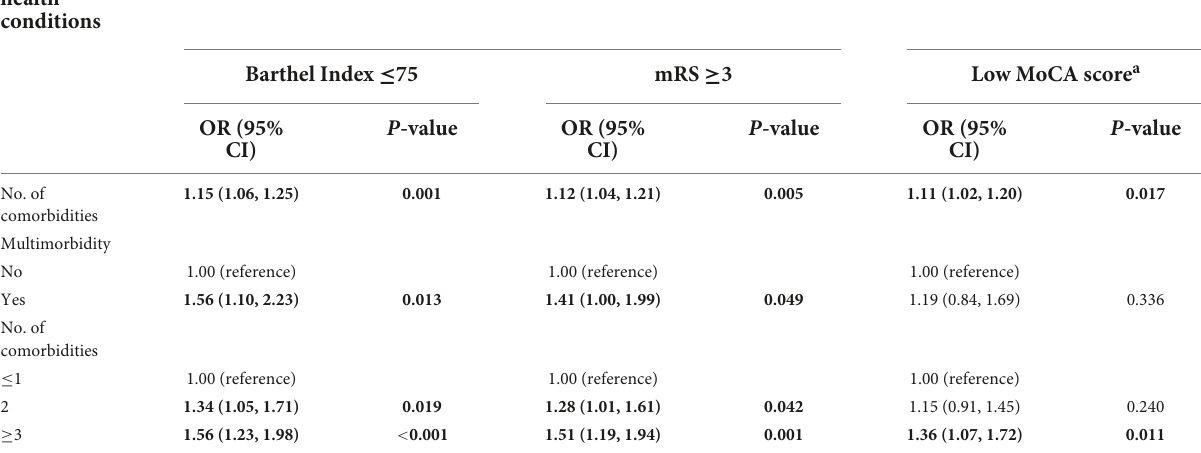
TABLE 3 Associations of physical and cognitive functions with number of chronic health conditions. Chronic